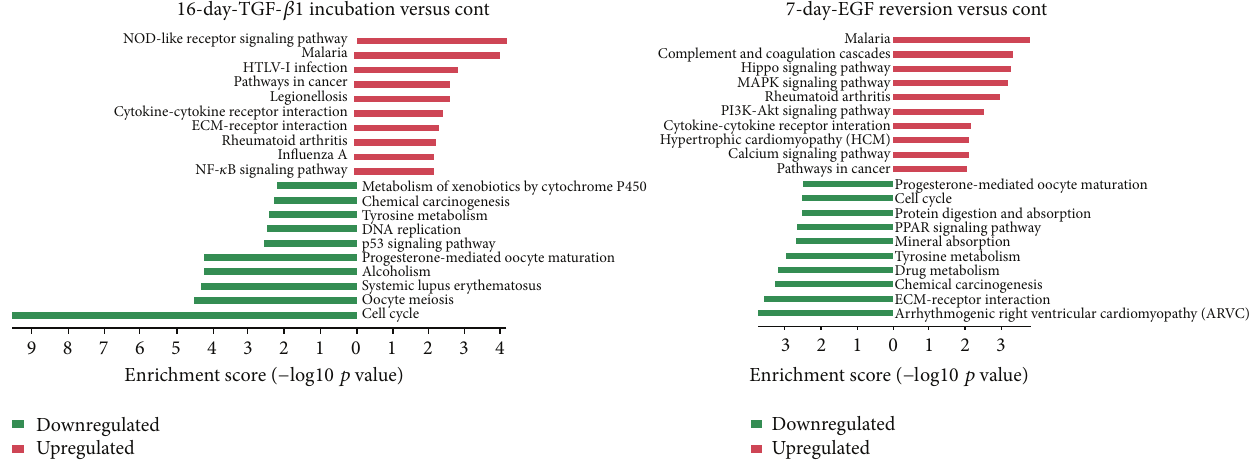
Figure 6: Top 10 upregulated (in red) and downregulated (in green) pathways in 16-day TGF- 𝛽 1 treated cells and 7-day EGF-reversion cells compared to control hepatic oval